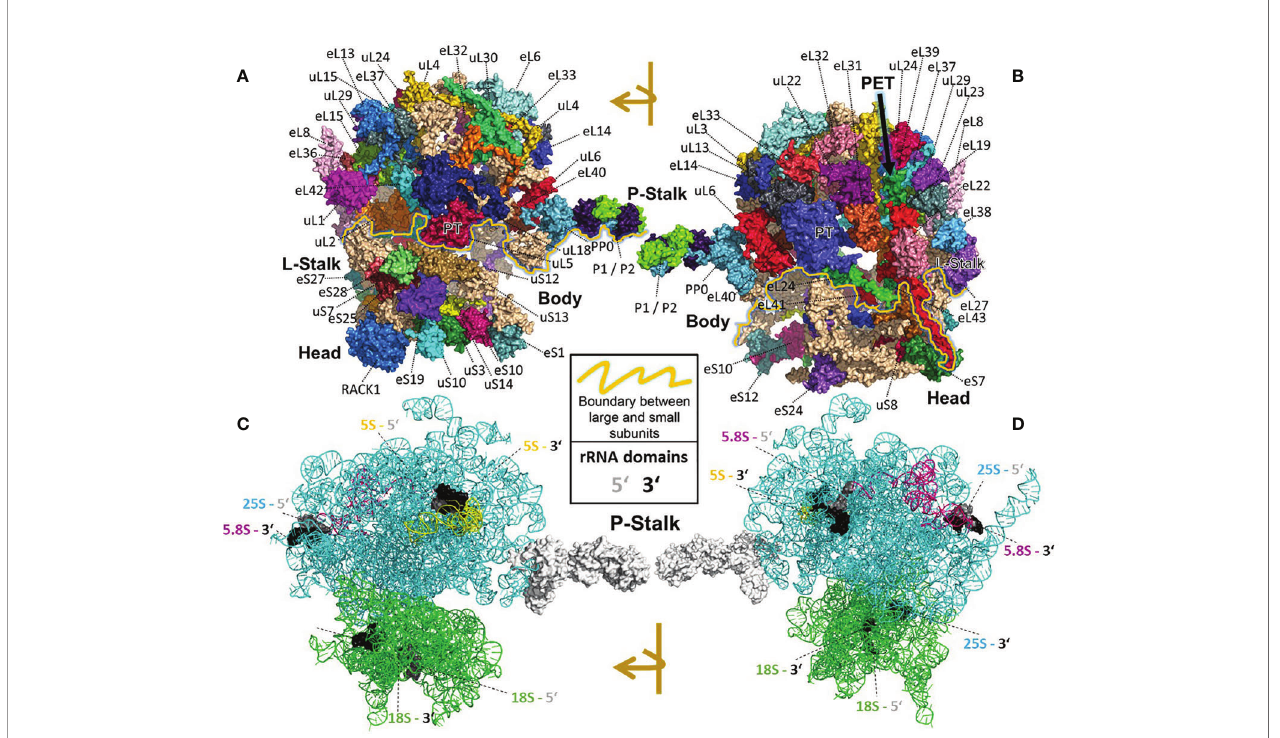
FIGURE 2 | Localization of RPs (top) or rRNAs (bottom) within the translating wheat 80S ribosome (Armache et al., 2010a; Armache et al., 2010b; Ben-Shem et al., 2011; Gamalinda et al., 2013) visualized by PyMOL (PyMOL, RRID : SCR_000305). RP localization was modeled at 5.5 Å resolution by combining structural data of wheat and yeast according to (Ben-Shem et al., 2010). rRNA chains are omitted from top panels (A, B) and are shown separately in bottom panels (C, D) without RP decorations except the P-Stalk that was added as a white surface outline for orientation. Each colored amino acid chain represents the position of a ribosomal protein family within the 40S SSU (lower part of the 80S ribosome) or in the 60S LSU (upper part). (A) Ribosome solvent surface. The main topological characteristics, P-stalk, L-stalk, head and body, and the 40S SSU to 60S LSU interface are indicated (yellow line). (B) Rotated ribosome. The interface and location of the polypeptide exit tunnel (PET, arrow) are indicated. (C, D) Rotated ribosome solvent and interface positions featuring the rRNA chains distinguished by colors. Positions of the four 5 ’ (grey) and four 3 ’ (black) ends of the 18S, 25S, 5.8S and 5S rRNAs are indicated by highlighting of the last ten nucleotide